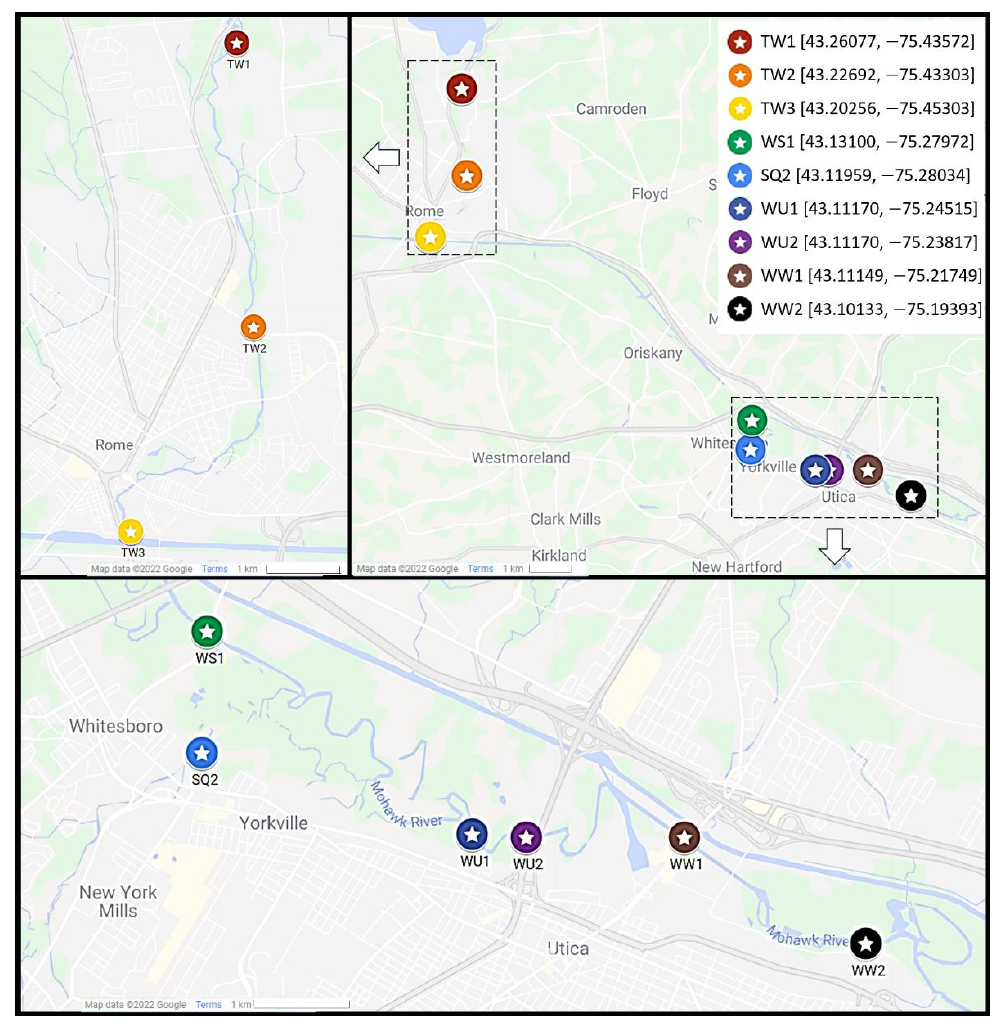
Figure 1. Mohawk River water quality sampling locations. Legend shows Sample ID followed by latitude and longitude.